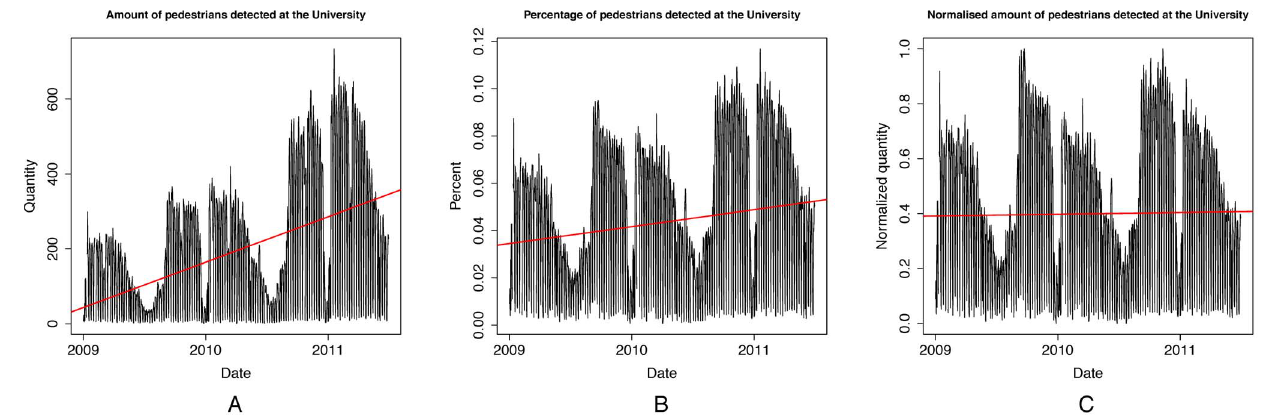
Figure 4. Normalisation of pedestrian flows time series. Figure 4a shows the number of WiFi devices detected during the study period in the lobby areas of our university. The data demonstrates strong seasonal patterns, for example showing that summer time is relatively quiet at the University. At the same time, however, this time series shows an upward trend, reflecting the increasing number of WiFi devices using the network across the city over time. To account for this increasing trend while maintaining the seasonal patterns, we normalise the data using a two-step approach. First we calculate the percentage of all devices seen on any day that visit a particular location on that day. Results of this normalization step are shown in Figure 4b. Subsequently, we apply an annual minimum-maximum normalisation filter to derive the time series in Figure 4c. The effectiveness of our normalization method is verified using linear regression (in red), which shows that compared to the original data ( x=0.3324, r 2 =0.2192, p , 2.2e-16 ) the normalization in Figure 4b ( x=1.964e-05, r 2 =0.04205, p=3.318e-12 ) and subsequently Figure 4c ( x=1.724e-06, r 2 = – 0.000879, p=0.9438 ) retain mostly seasonal patterns in variation.